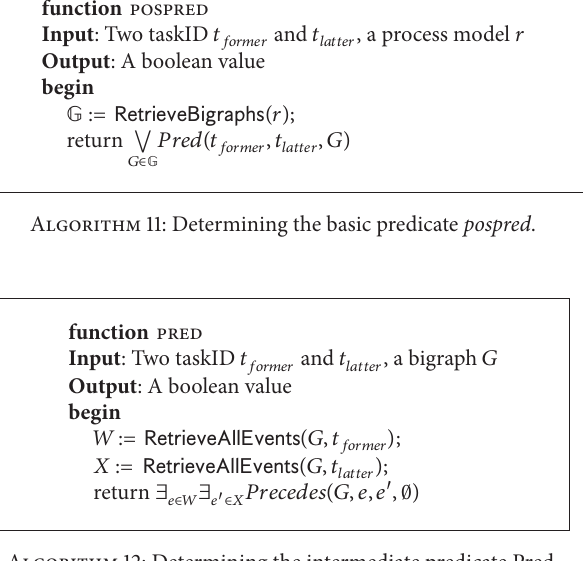
Algorithm 12: Determining the intermediate predicate